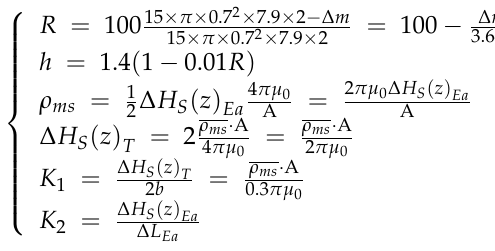
Table 3. The calculation parameters of gradient K.